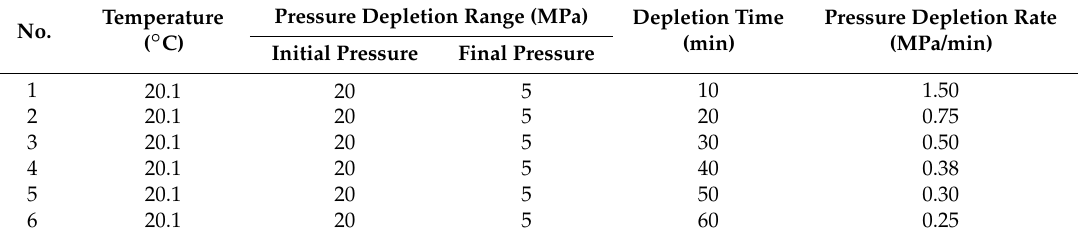
Table 3. Linear pressure depletion experiment with six different depletion rates.